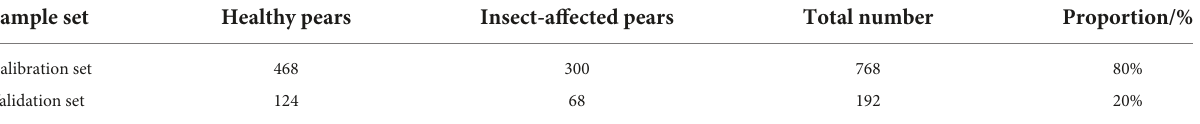
TABLE 1 Sample set